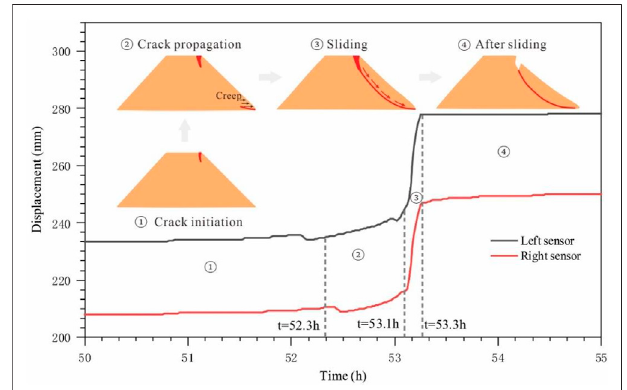
FIGURE 11 | Variation of displacement on the dam crest during the second